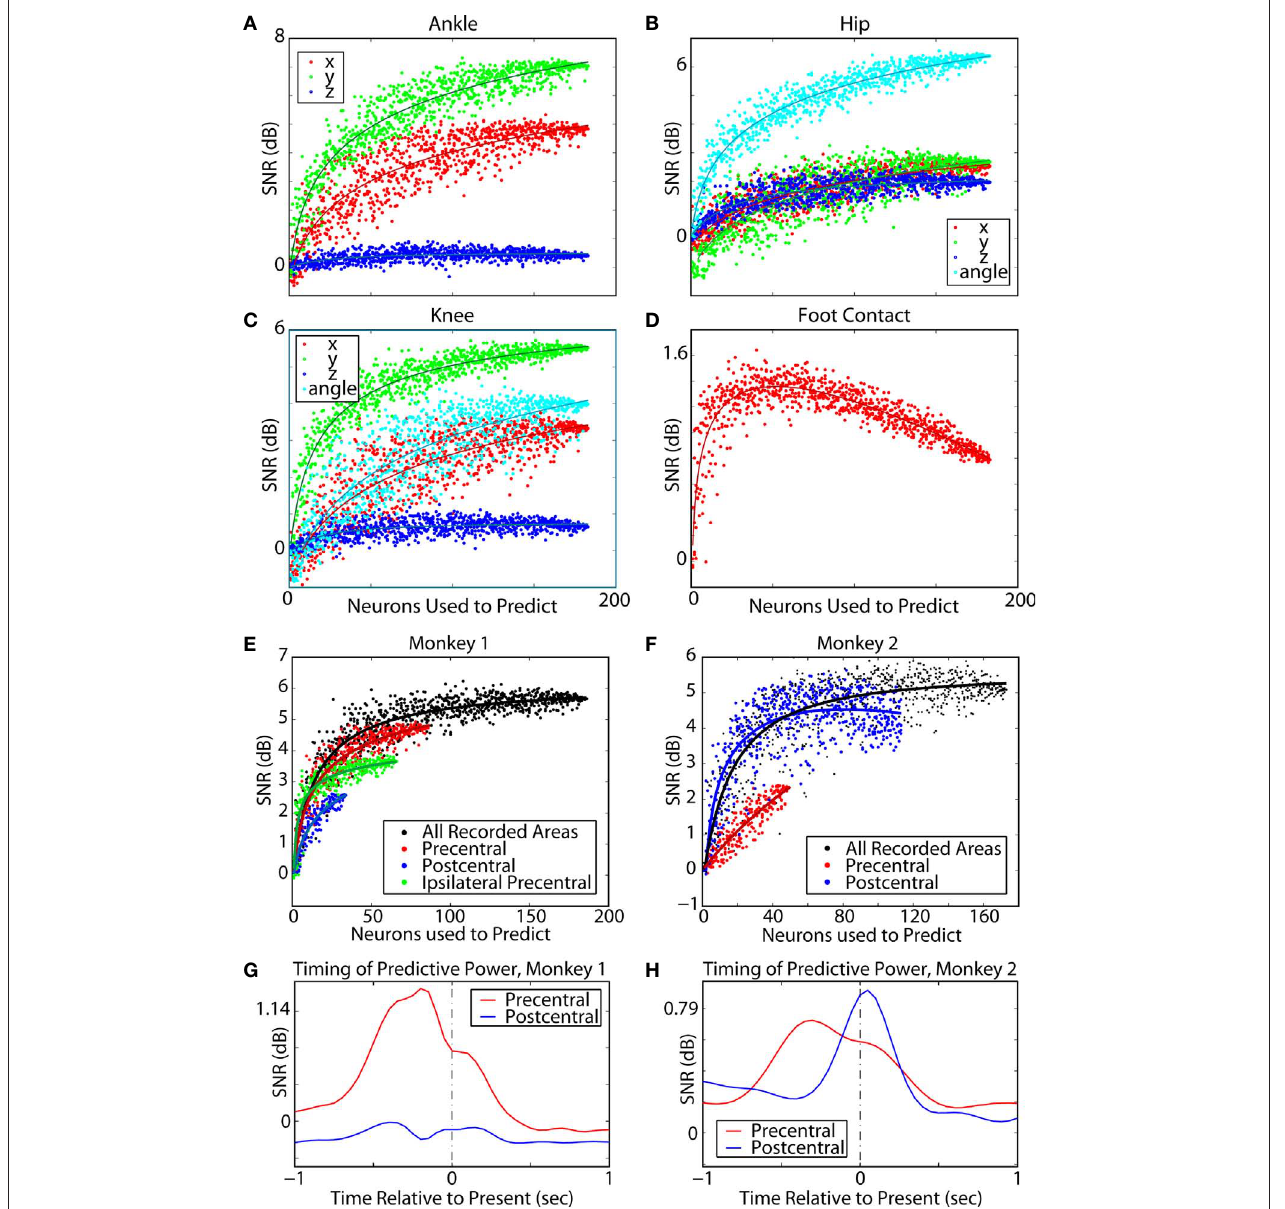
FIGURE 6 | Neuronal dropping curves for simultaneously extracted variables. Dots represent SNR for the extraction of walking parameters using models trained on randomly selected neuronal populations of different sizes. In ( A–C ) red dots correspond to X coordinate, green dots to Y, and blue dots to Z. In ( B,C ) cyan dots correspond to joint angles for the respective joint. This analysis showed that prediction accuracy increased with the neuronal sample size [but see (D) ]. Extraction analysis by cortical area was also performed for Monkey 1 (E,G) and Monkey 2 (F,H) . In Monkey 1, more cells were recorded in M1 than in S1, whereas in Monkey 2 more cells were recorded in S1. (A) 3D coordinates of the ankle. (B) Joint angle and 3D coordinates of the knee. (C) Joint angle and 3D coordinates of the hip. (D) Foot contact, that is whether or not the monkey’s foot